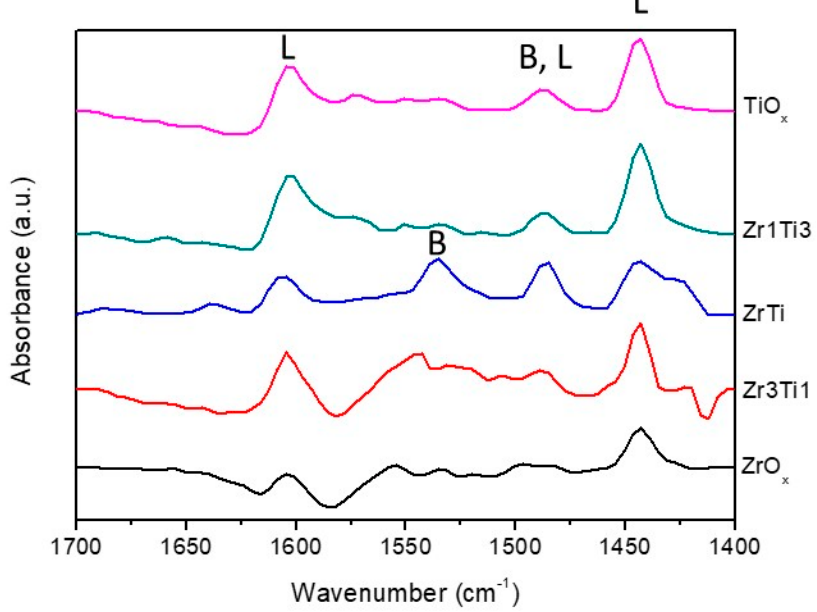
Figure 8. Diffuse reflectance infrared Fourier transform (DRIFT) studies of pyridine chemisorbed on the Zr–Ti solids. B and L stand for Brönsted and Lewis acid sites, respectively.